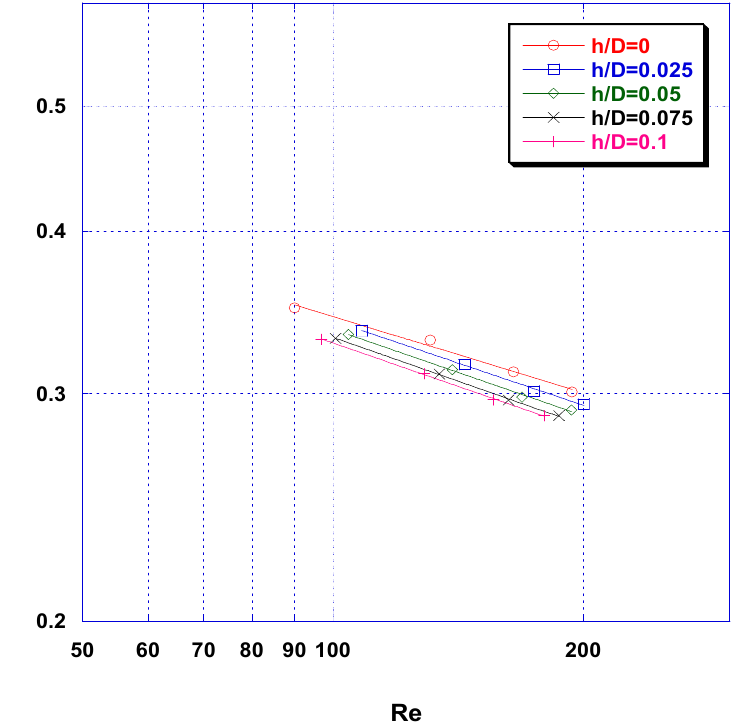
Figure 6. Friction factor versus Reynolds number for various thicknesses of fouling layer.